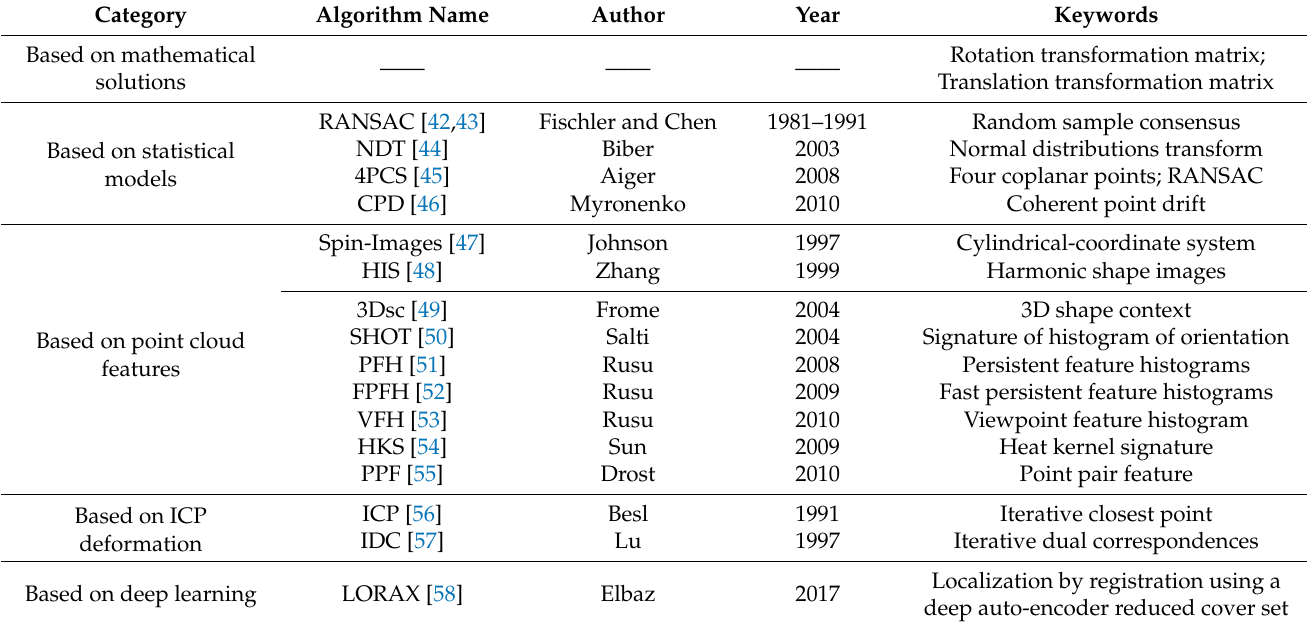
Table 2. A brief summary of classical registration